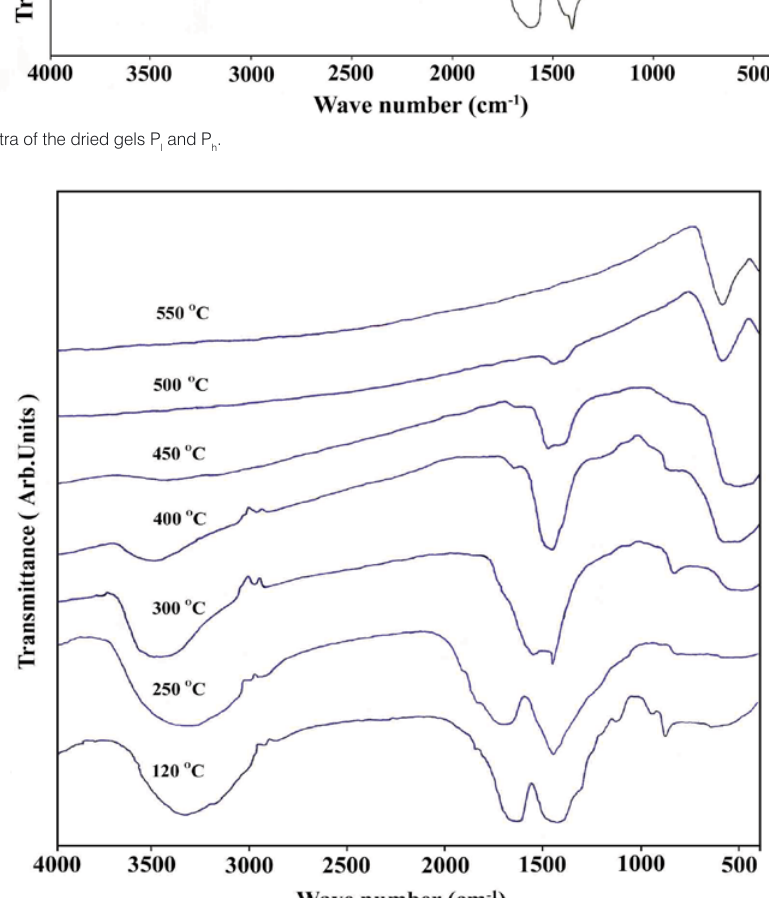
Figure 3. IR spectra of citrate precursor P